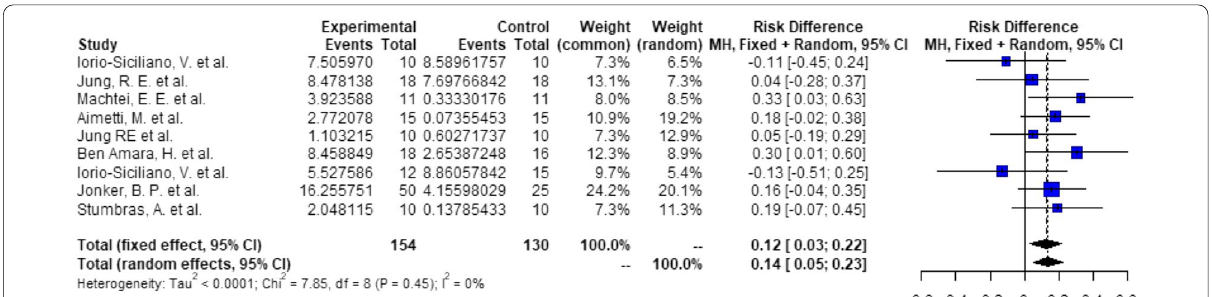
Fig. 7 Meta-analysis results for the binary outcomes for implant placement in a bone envelope of 8.0 mm